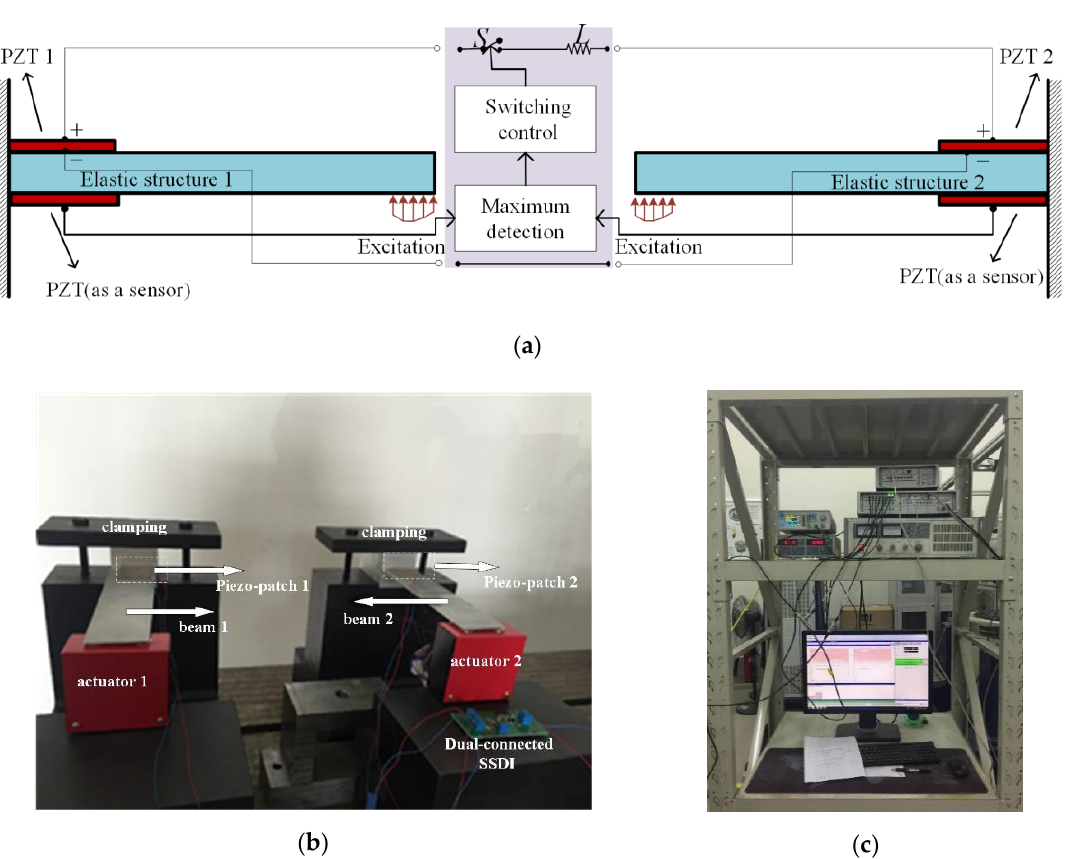
Figure 10. Setup of the double-beam test rig: ( a ) the schematic plot; ( b ) the photo of the test rig where each beam is individually excited; ( c ) the auxiliary equipment.